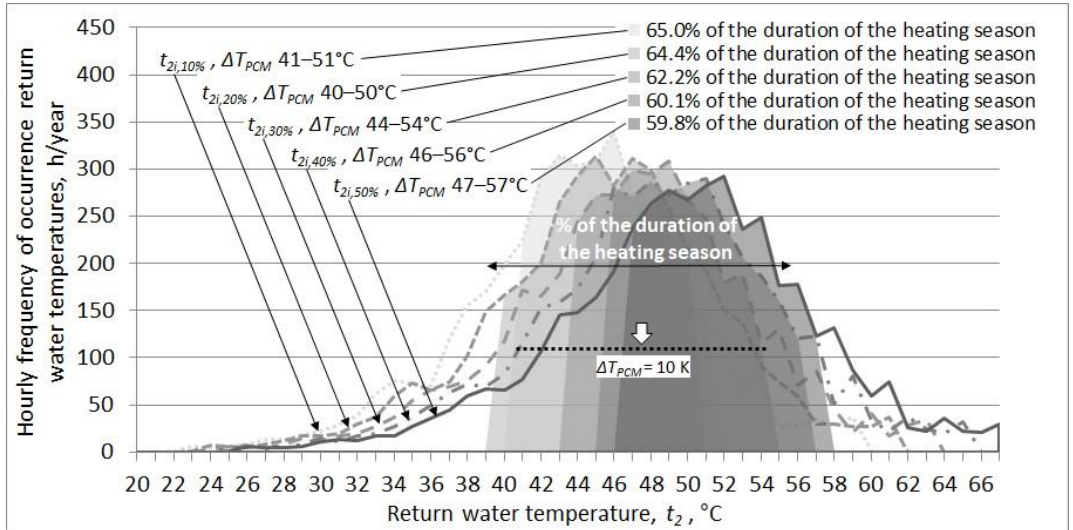
Figure 7 . Hourly frequency of occurrence of return water temperatures . Figure 7. Hourly frequency of occurrence of return water